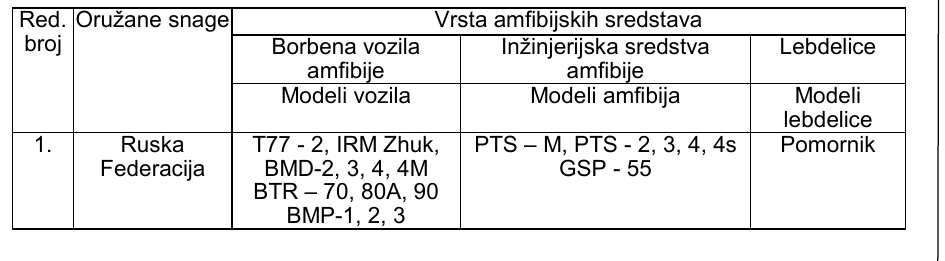
Table 2 – List of the amphibious assets in the Russian Federation Red. Oružane snage Vrsta amfibijskih sredstava broj Borbena vozila Inžinjerijska sredstva amfibije amfibije Modeli vozila Modeli